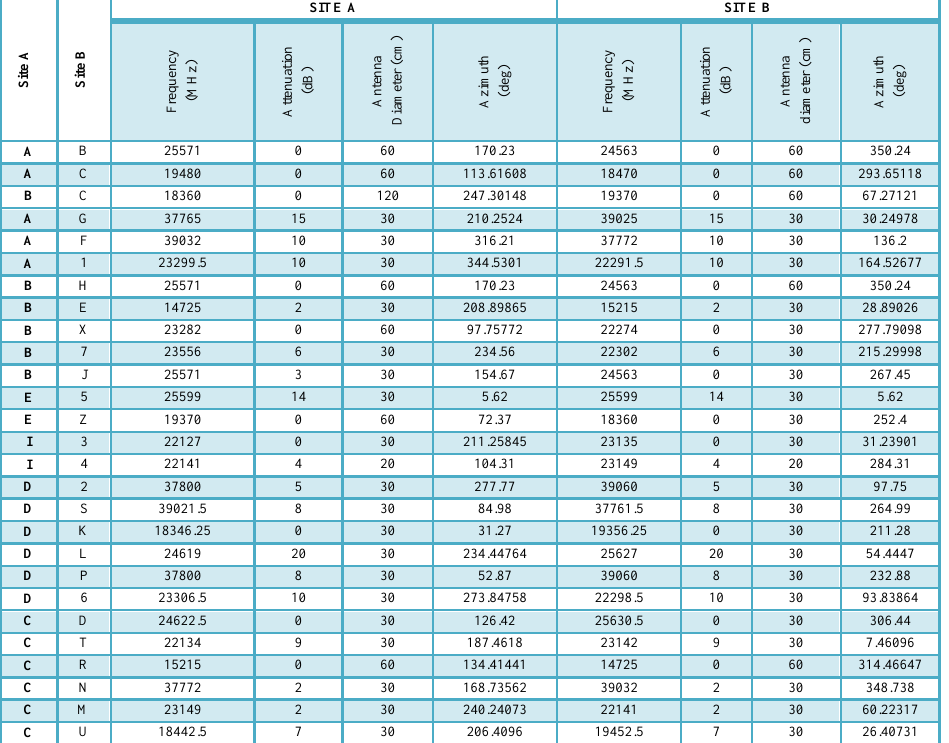
Table 2. Radio parameters of the links projected , part I